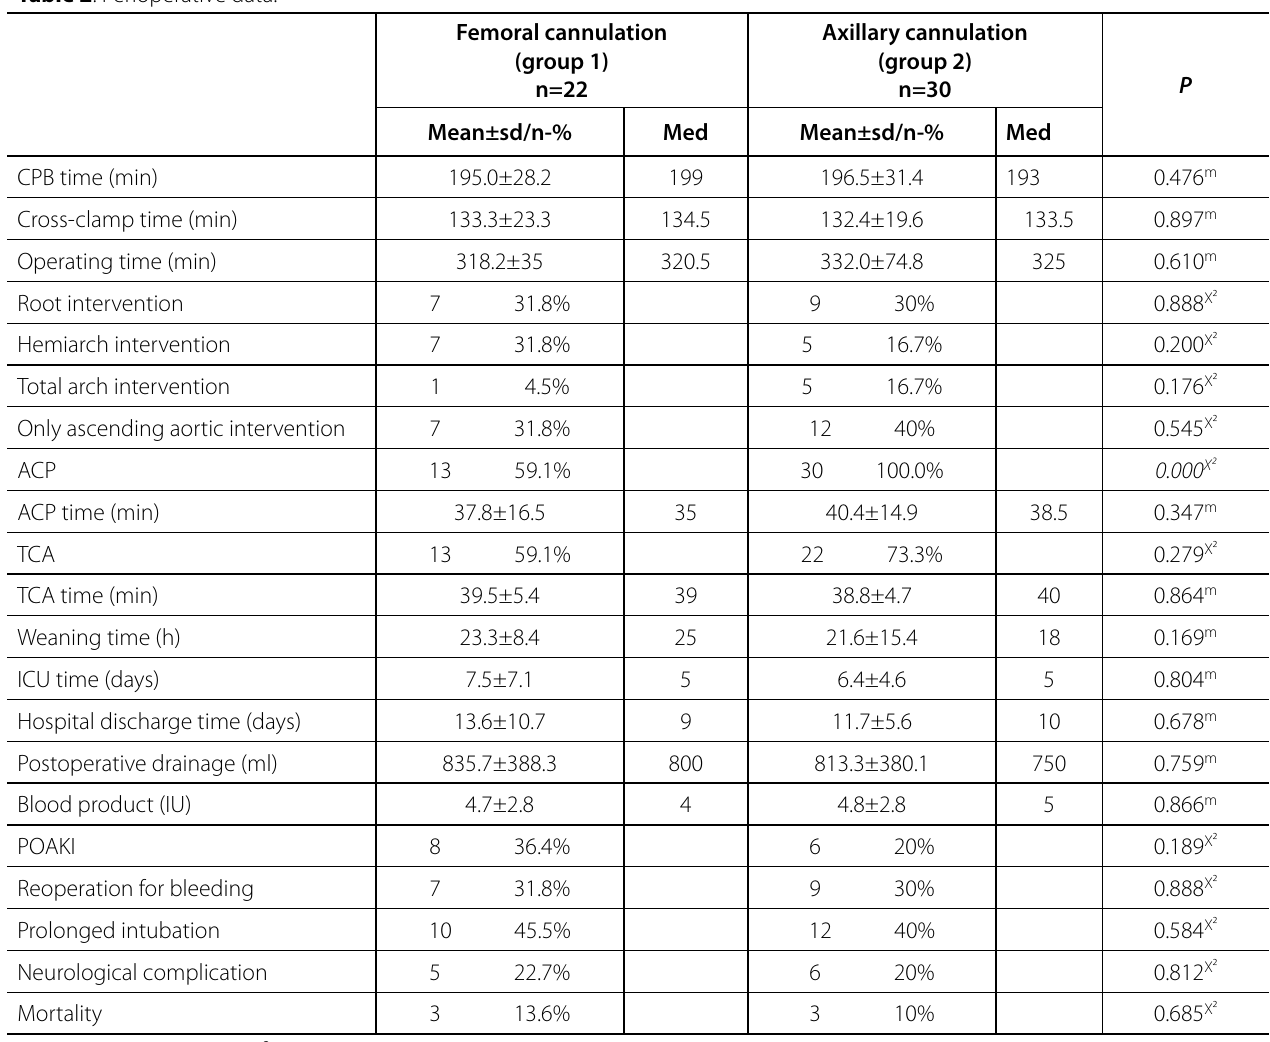
Table 2 . Perioperative